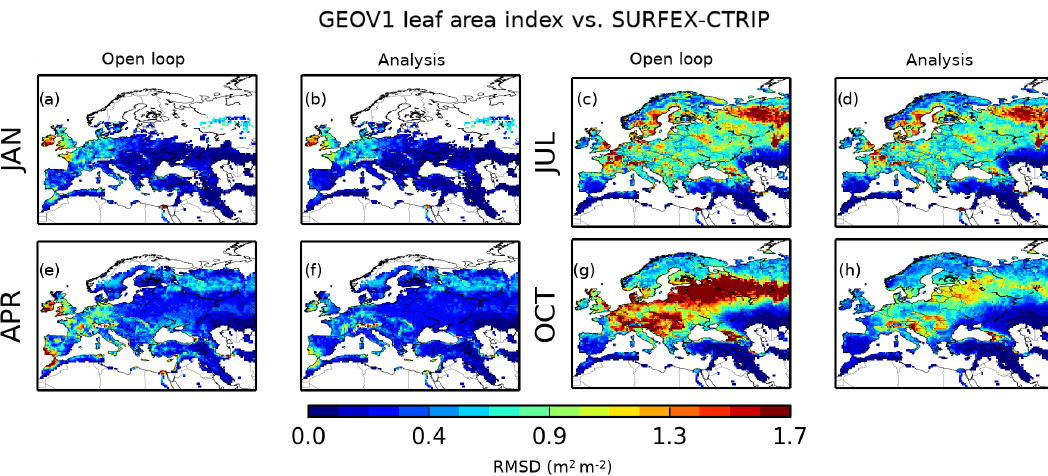
Figure 7. RMSD maps between leaf area index from the open loop (analysis) and that from the Copernicus Global Land Service project GEOV1 index for (a, b) January, (e, f) April, (c, d) July and (g, h) October over 2000–2012.